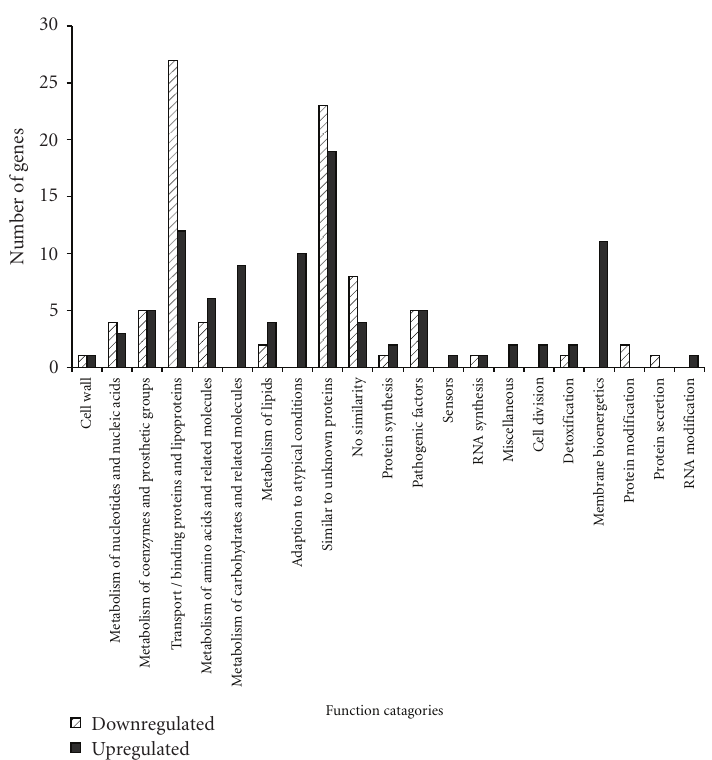
Figure 2: CT-responsive genes grouped by functional classification. The di ff erentially regulated genes were divided into 33 functional categories. The number of genes upregulated and downregulated for each functional group was represented.